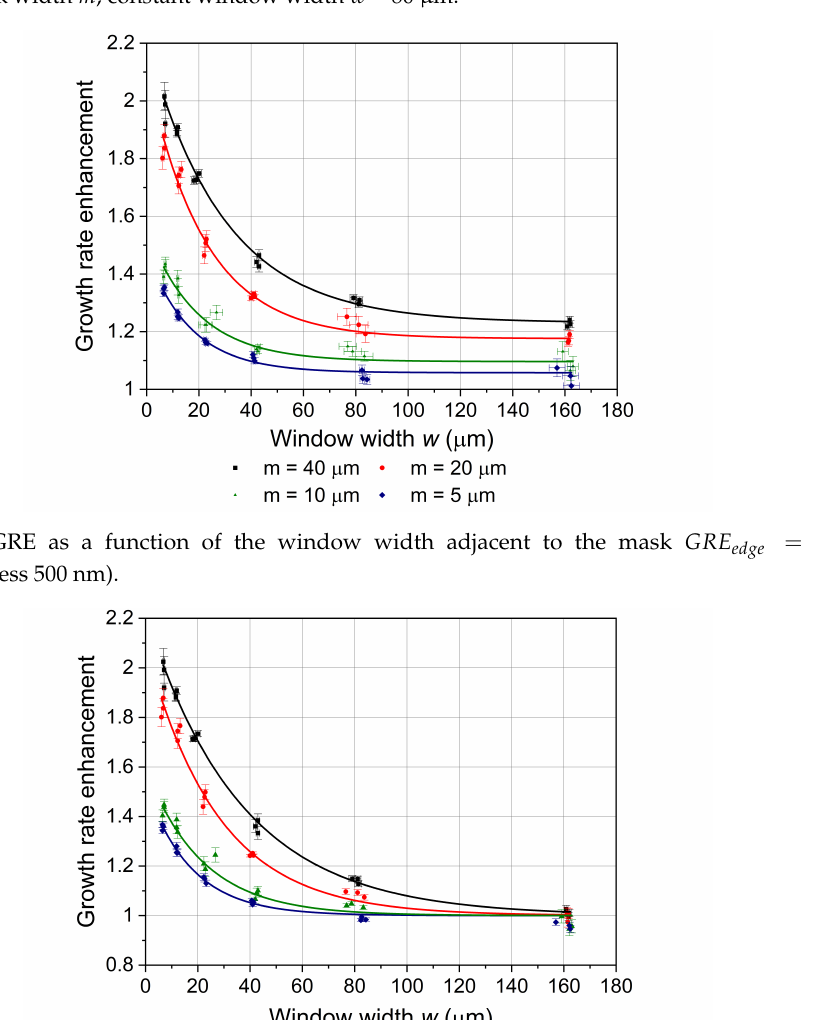
Figure 6. GRE as a function of location relative to the window center (layer thickness 500 nm). Variable mask width m , constant window width w = 80 µ m.